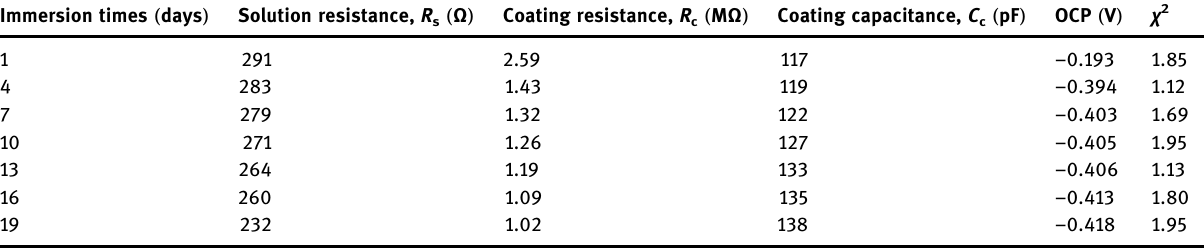
Table 2: EIS parameters of ROHA coatings in 3.5w/w% NaCl at room temperature Immersion times ( days )